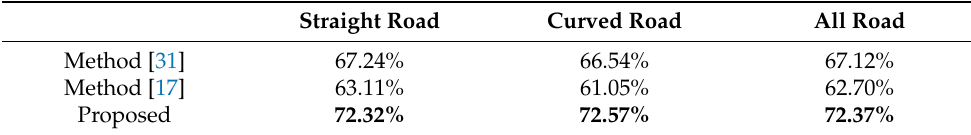
Table 4. The P-IoU results of the SemanticKITTI